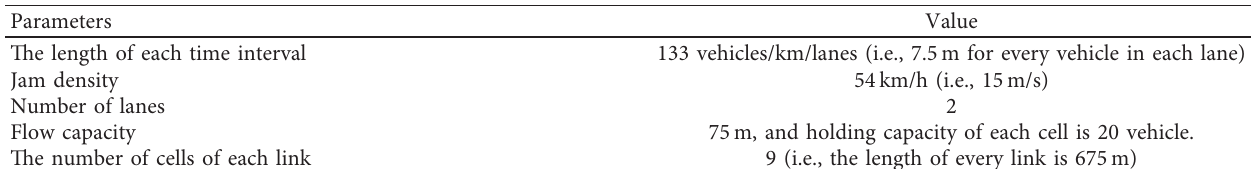
Table 4: CTM parameters [44] for the scenario 3.